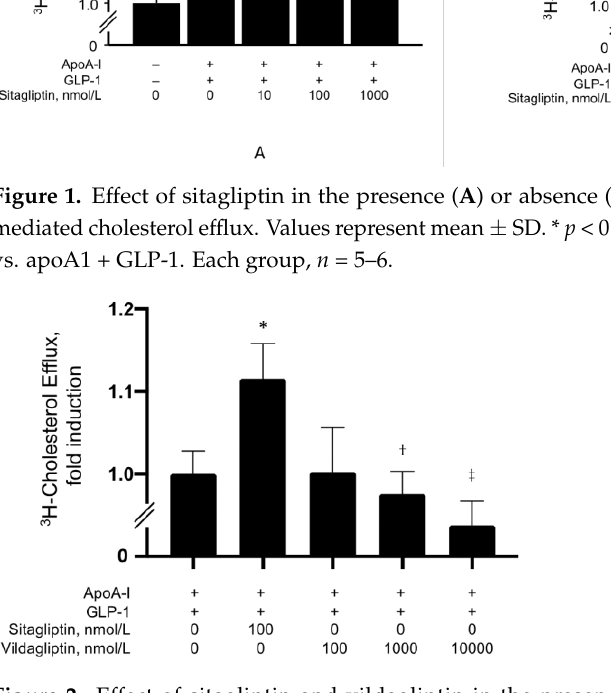
Increased by Sitagliptin Phosphate In contrast, the ABCA1 mRNA expression was not significantly increased following treatment with sitagliptin phosphate in the presence of GLP-1 (Figure 3A). Furthermore, sitagliptin phosphate did not affect the whole-cell expression of ABCA1 protein (Figure 3B). Figure 3. Effect of sitagliptin in the presence of GLP-1 (10 nmol/L) on ABCA1 mRNA ( n = 8 – 12) ( A ) and protein ( n = 5) ( B ). Expressions in whole-cell lysates of THP-1 cells. Values represent mean ± SD. Abbreviations: ABCA1, adenosine triphosphate-binding cassette transporter A1; GAPDH, glyceraldehyde-3-phosphate dehydrogenase. Interestingly, the ABCA1 protein expression was significantly elevated in the mem- brane fraction by sitagliptin phosphate in the presence of GLP-1 (Figure 4A), but not in its absence (Figure 4B). The elevated ABCA1 protein expression due to sitagliptin phosphate in the membrane fraction was slightly decreased following preincubation with the GLP- 1R antagonist exendin-(9 – 39); however, this result was not statistically significant (Figure 4A).